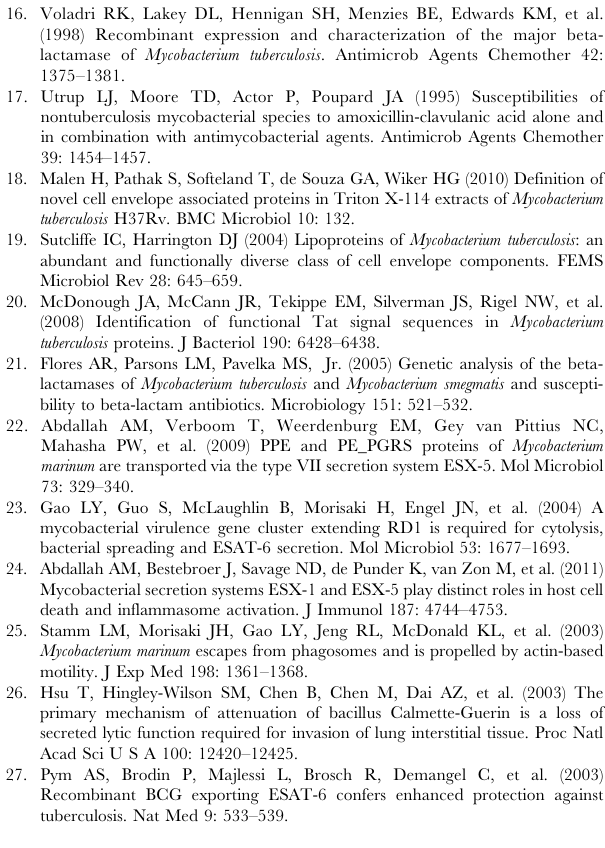
Figure S8 Necrosis induction does not influence the subcellular localization of mycobacteria. THP-1 cells were